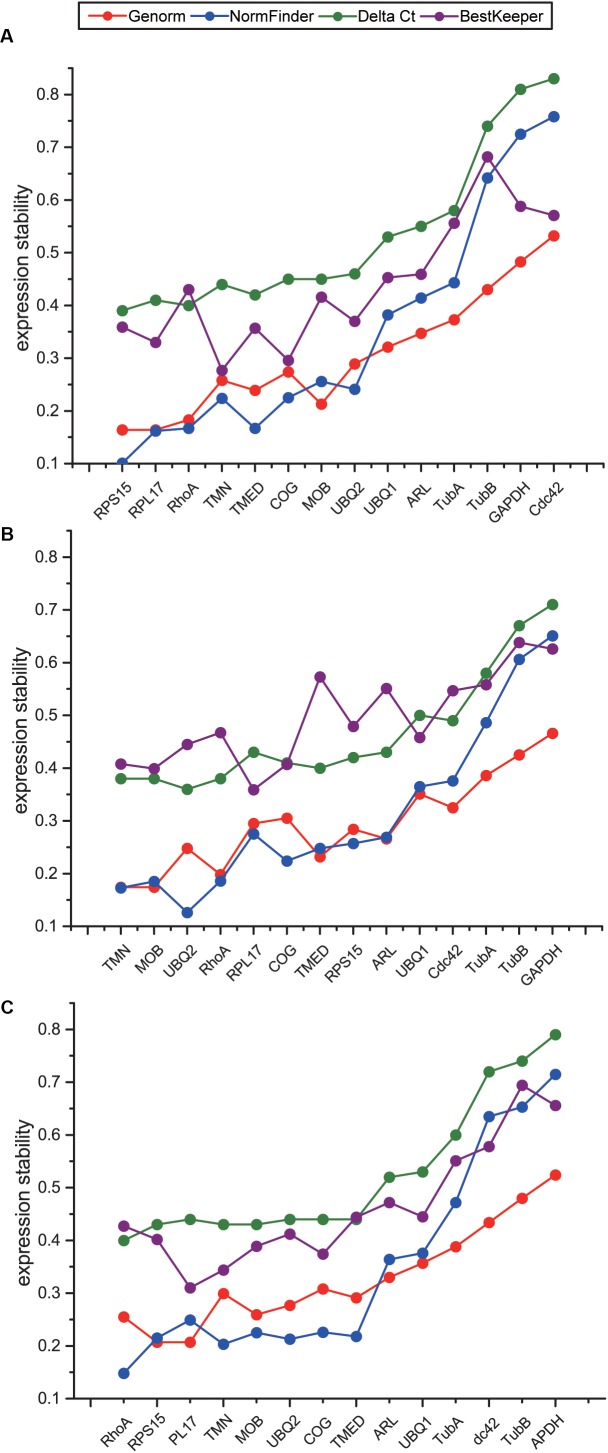
Comparison of expression stability of 14 candidate reference genes using Genorm, NormFinker, Delta Ct, and BestKeeper under temperature stress (A), salinity stress (B), and the combination of temperature and salinity stresses (C). The sequence of genes on X axis indicates the comprehensive results obtained with RefFinder, according to the order from the most stable genes to the least stable genes.